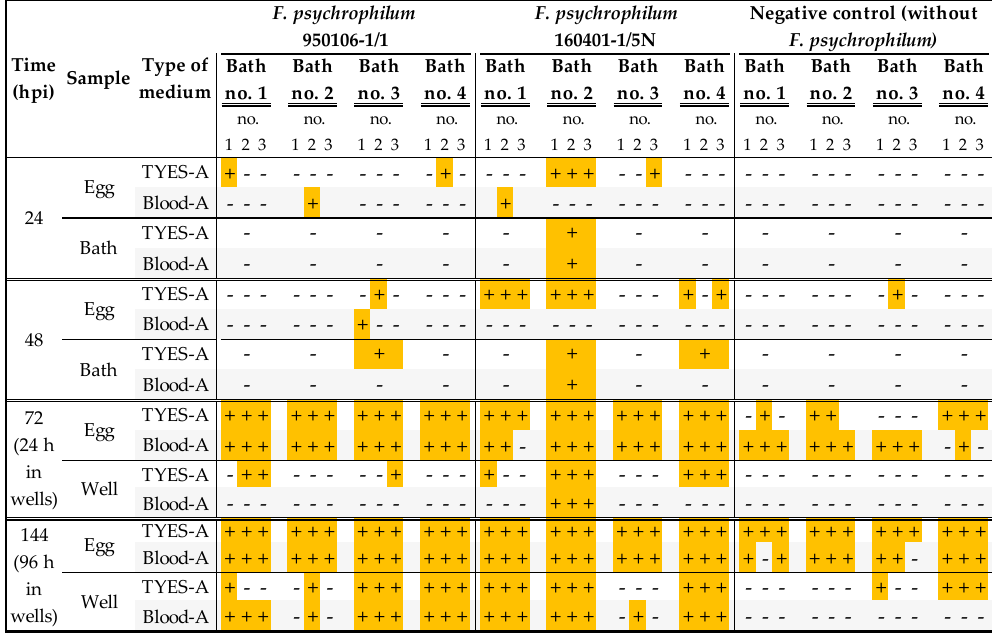
Figure A3. Exp. I section C: characteristics of sampled eggs. hpi = hours post infection. Bath no. 1: phage bath with of 10 9 PFU mL − 1 ; Bath no. 2: phage bath with 10 8 PFU mL − 1 ; Bath no. 3: control bath with SM buffer; Bath no. 4: control bath with Milli-Q water.